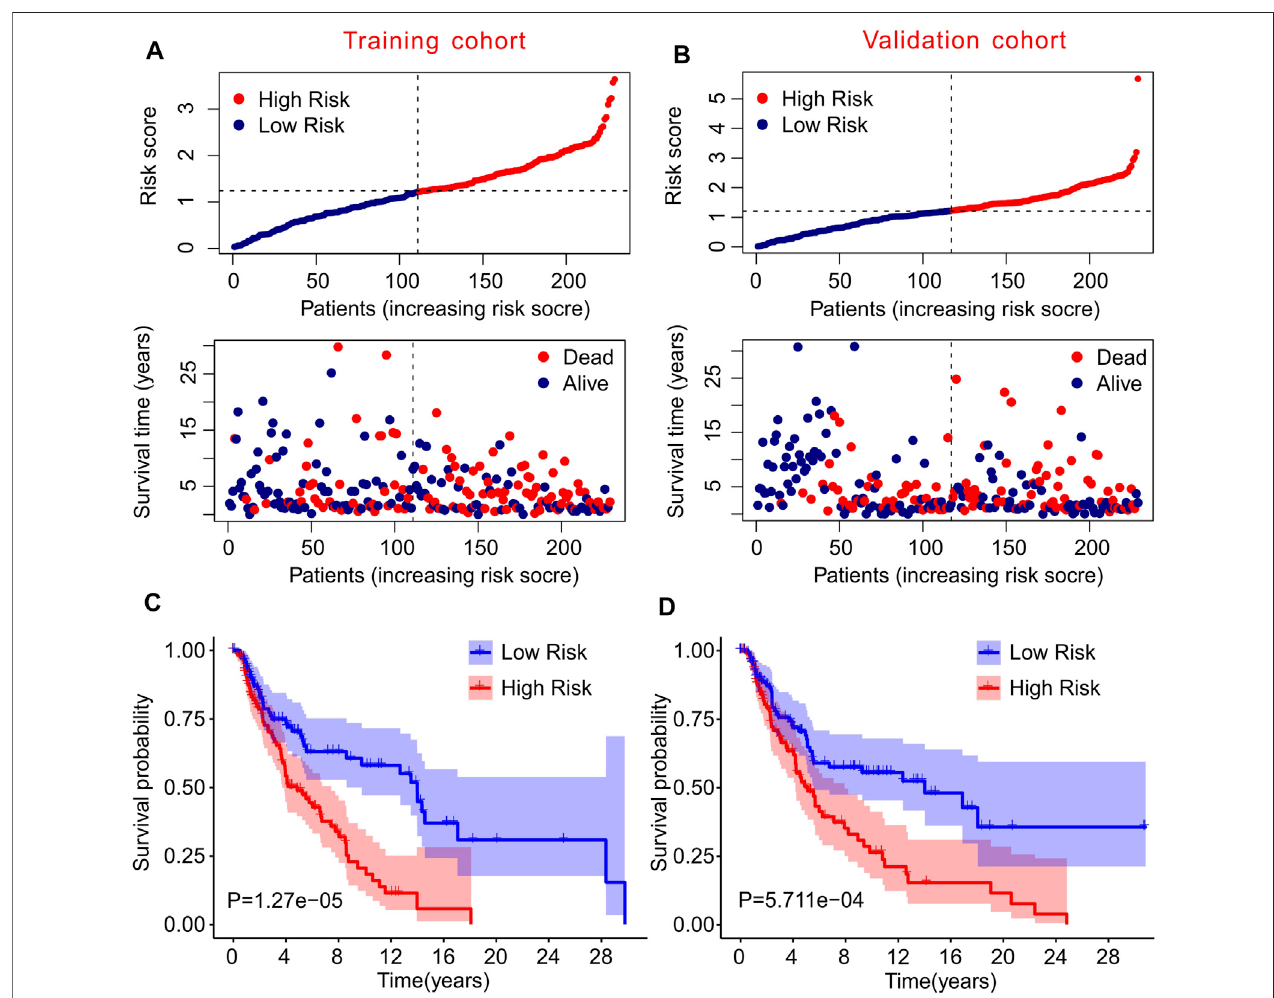
FIGURE 3 | Risk model of training cohort and validation cohort. (A,B) The distribution of risk scores and scatter dot plot of CM patients based on the autophagy- related lncRNAs prognostic signature in training cohort and validation cohort. (C,D) The survival curve analysis shows that the survival time in CM patients with high-risk scores is signi fi cantly shorter than those with low-risk scores in training cohort and validation